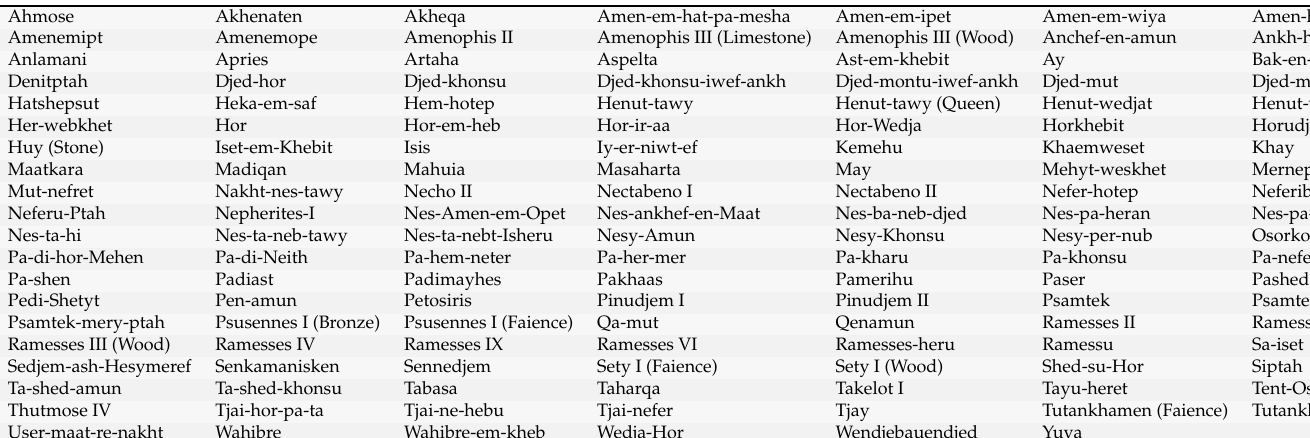
Table 3. List of categories (Shabti’s